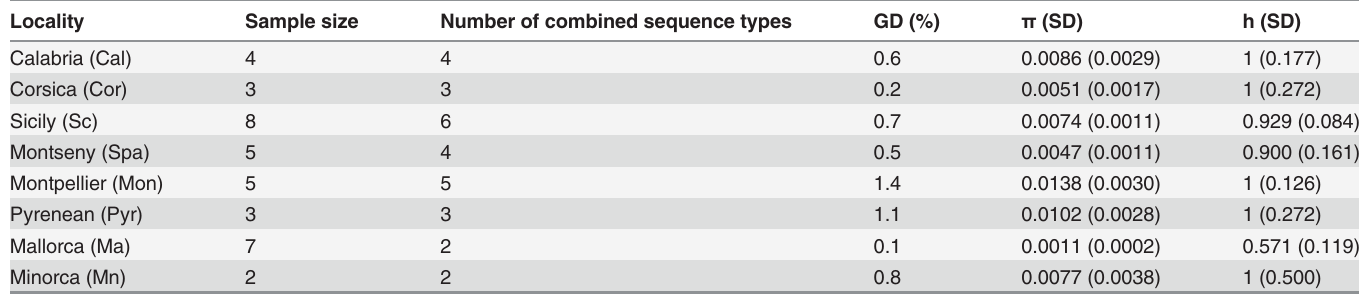
Table 4. Genetic variability of Pneumocystis concatenated mtLSU and mtSSU sequences observed within each host locality. Locality